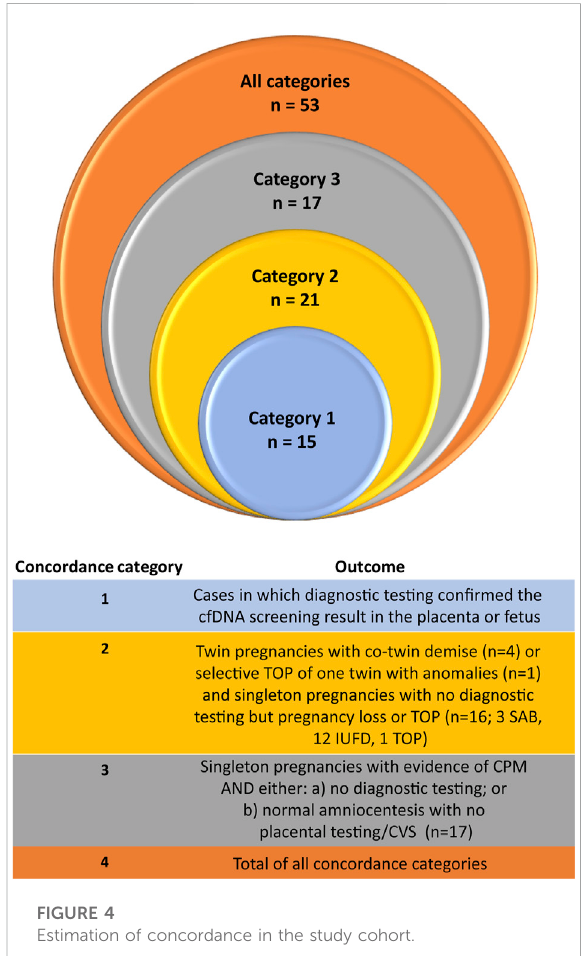
FIGURE 4 Estimation of concordance in the study